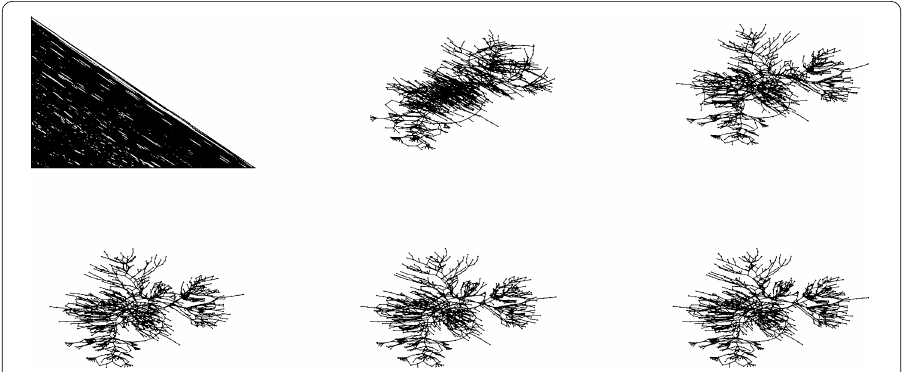
Figure 2 Stress majorization applied to graph 1138_bus after 10, 20, 30, 40 and 47 iterations,